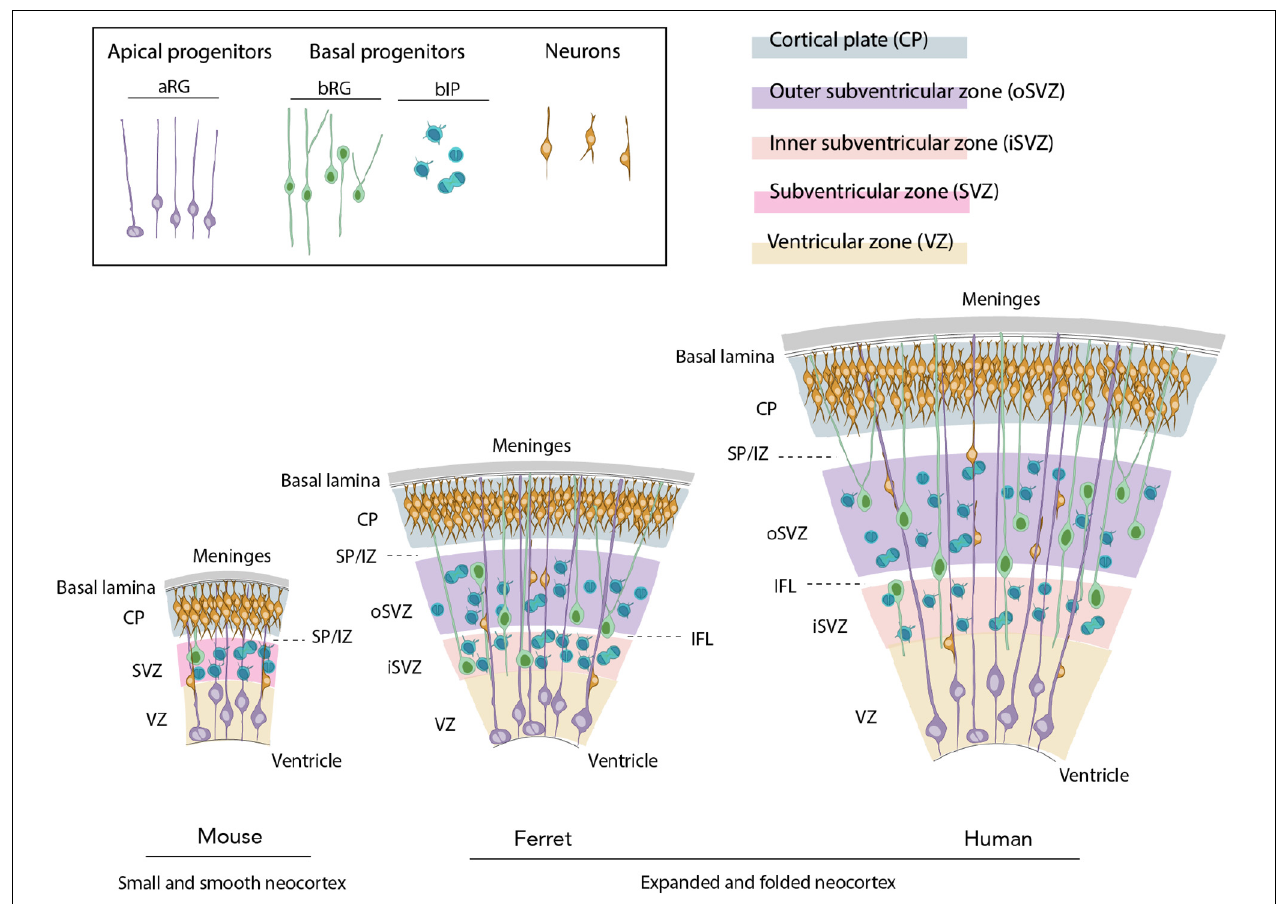
FIGURE 1 | Evolutionary expansion of the neocortex. Ferret and human develop an expanded and folded neocortex, whereas the mouse is characterized by a small and smooth neocortex. The key features of the former are a high abundance of basal progenitors (BP) and particularly basal radial glia (bRG), their morphological heterogeneity, distinction of iSVZ and oSVZ, existence of the inner fiber layer (IFL) and a tangential migration of projection neurons through the germinal zones, intermediate zone (IZ), and subplate (SP) to their final position in the CP.